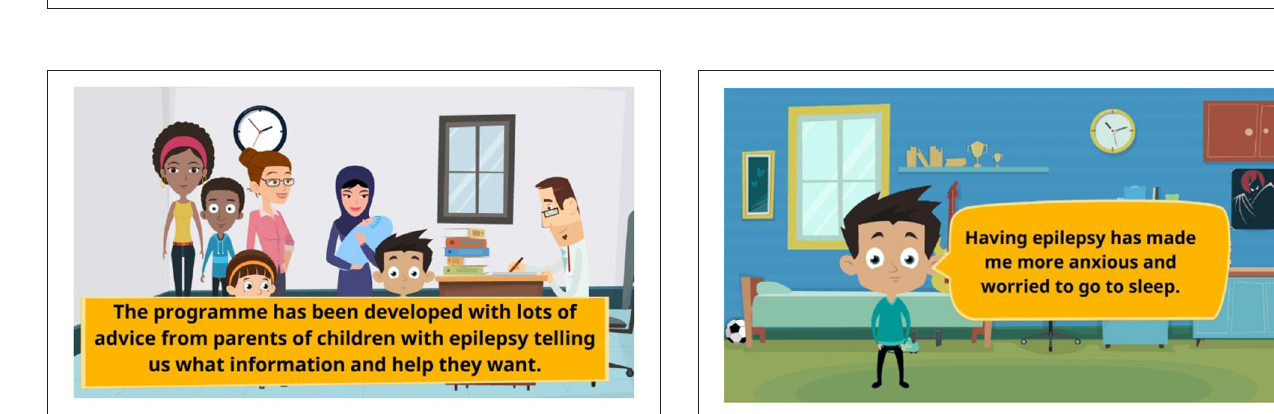
FIGURE 1 | Personalised recommendations for modules based on parental responses to screening questionnaire.